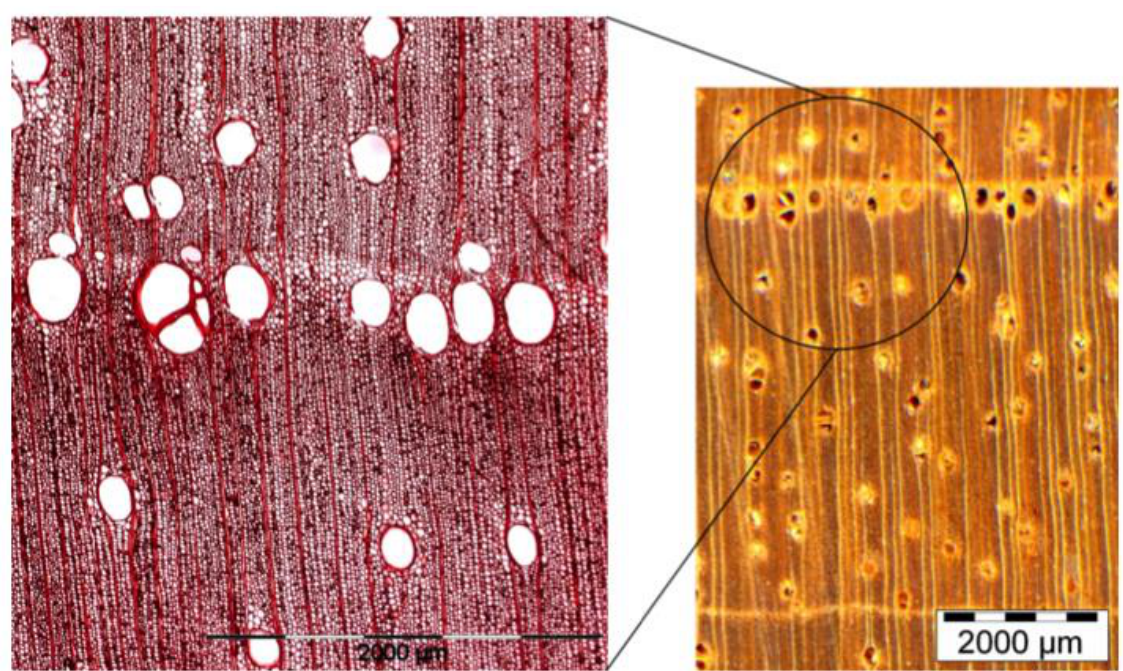
Figure 3. Microsection ( left ) and tree-ring boundaries ( right ) of C. odorata.